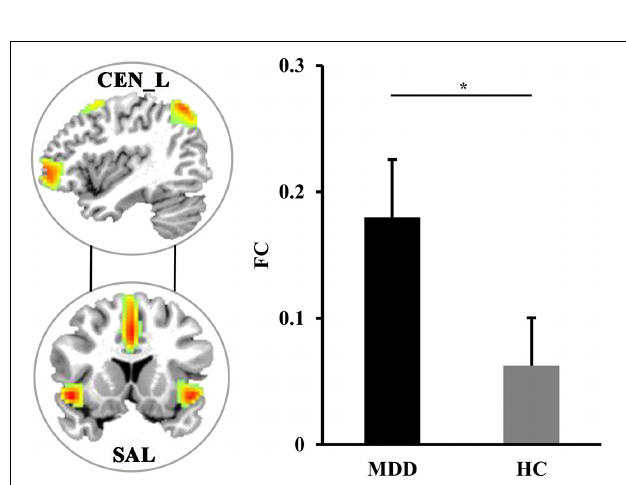
FIGURE 2 | The differences in functional network connectivities. The significantly increased functional network connectivity between the left central executive network (CEN_L) and salience network (SAL) was found in MDD patients. *Represents significant